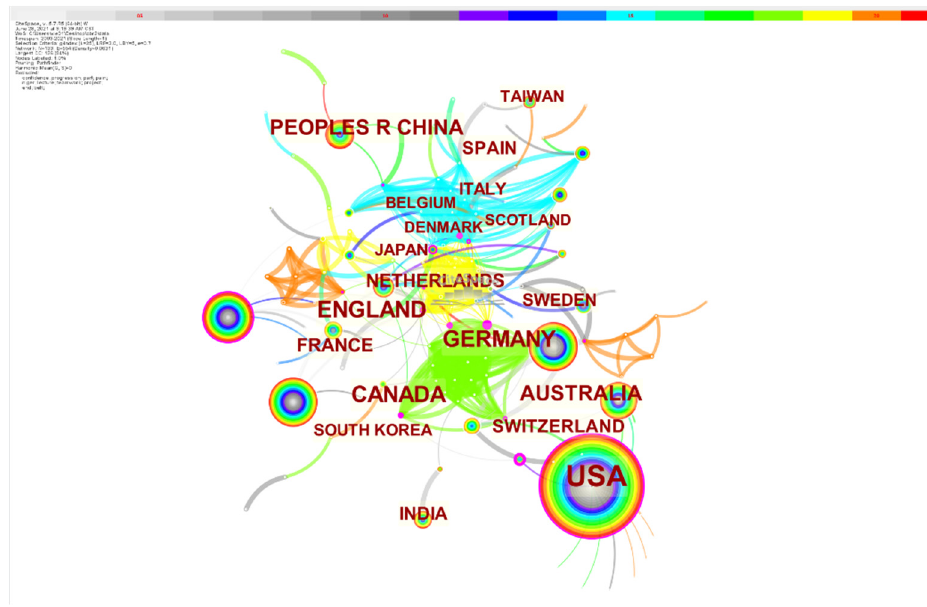
Figure 2. Top 20 countries and regions in terms of publication volume on CBR literature.